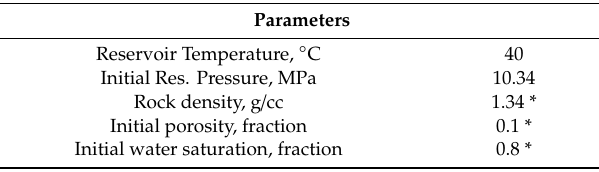
Table 2. Parameters used for initial gas reserves estimates.